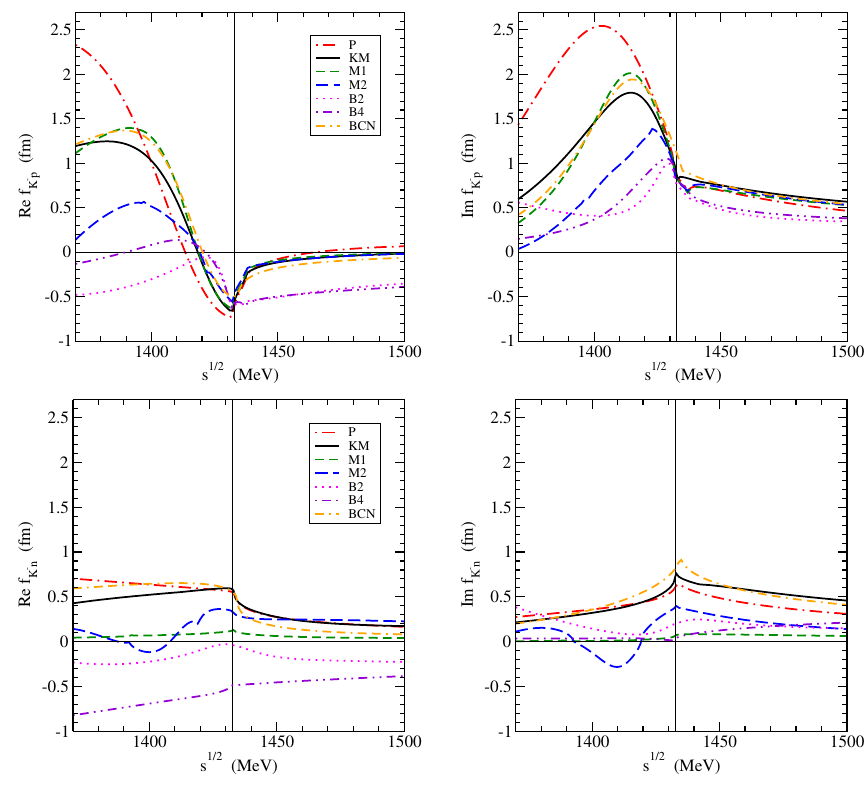
Figure 1. Real (left) and imaginary (right) parts of the s -wave free-space K − p (top panel) and K − n (bottom panel) amplitude in the state-of-the-art chiral